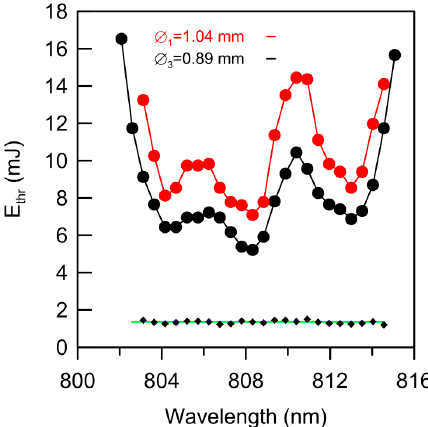
Figure 7. Threshold pump energy as a function of pump wavelength at two different pump beam diameters: Ø 1 = 1.04 mm ( red ) and Ø 3 = 0.89 mm ( black ). As can be seen, the ratio between both curves is nearly constant ( black diamonds ) and equal to the beam area ratio ( green line ).